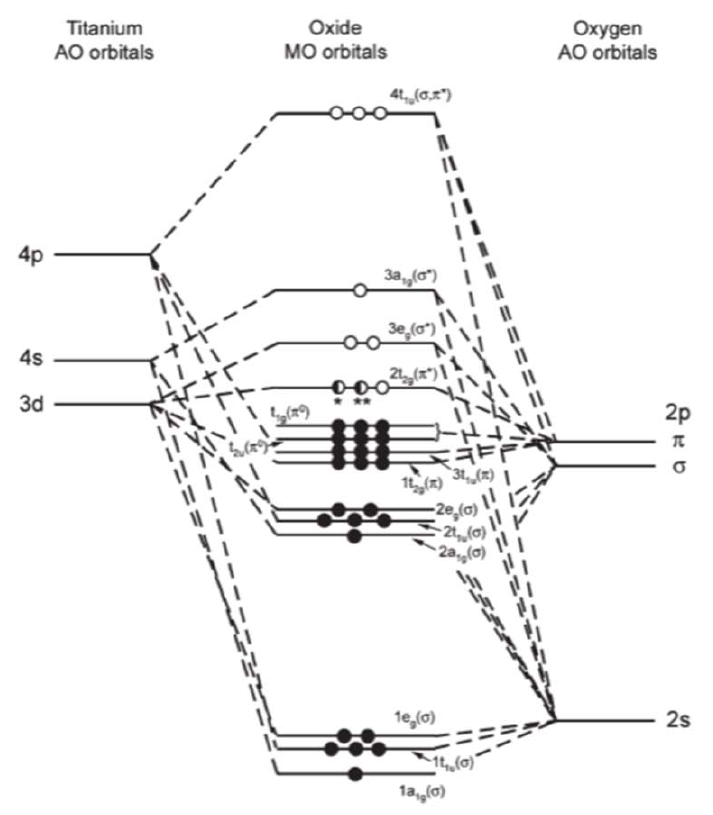
Figure 9. Molecular orbital diagram of TiO 2 , Ti 2 O 3 , TiO. Reproduced from [90], Copyright 2007, American Mineralogist.